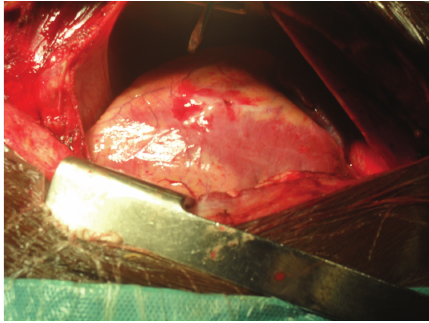
Figure 4: Image of heart stab wound with vein injury after screwdriver